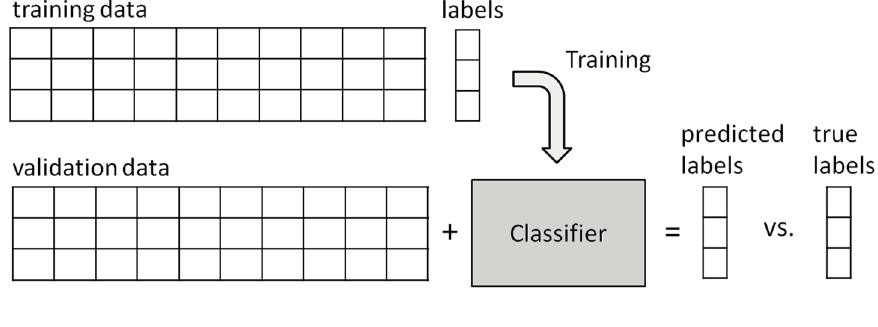
Figure 2. Classifier training.